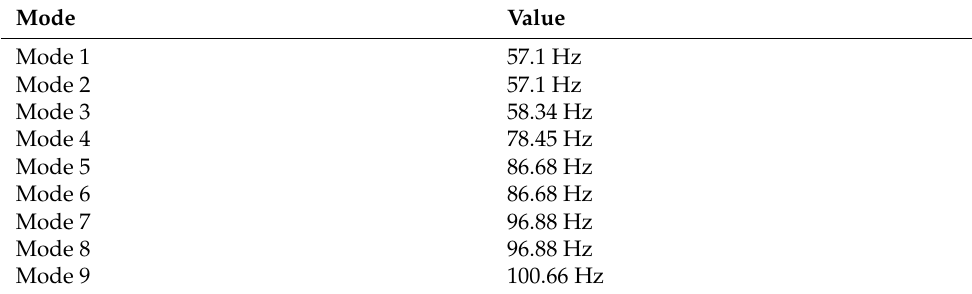
Table 9. Different modes and associated natural frequencies of the structure.